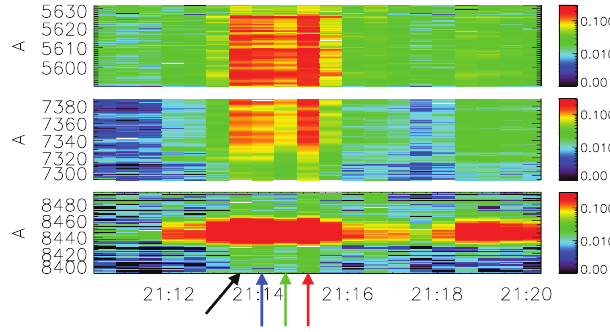
Fig. 5. SIF spectra for event 2. In panel O + (5620) (top panel) O + 2 2 1N bands excited in the E-region are seen. In panel O + (7319)), the oxygen doublet is overwhelmed by emission caused by the N 2 1PG band, which is a typical high energy aurora feature. The bottom panel (panel OI(8446)) shows the oxygen line emission during this event. The arrows mark the times of the ASK images in Fig.